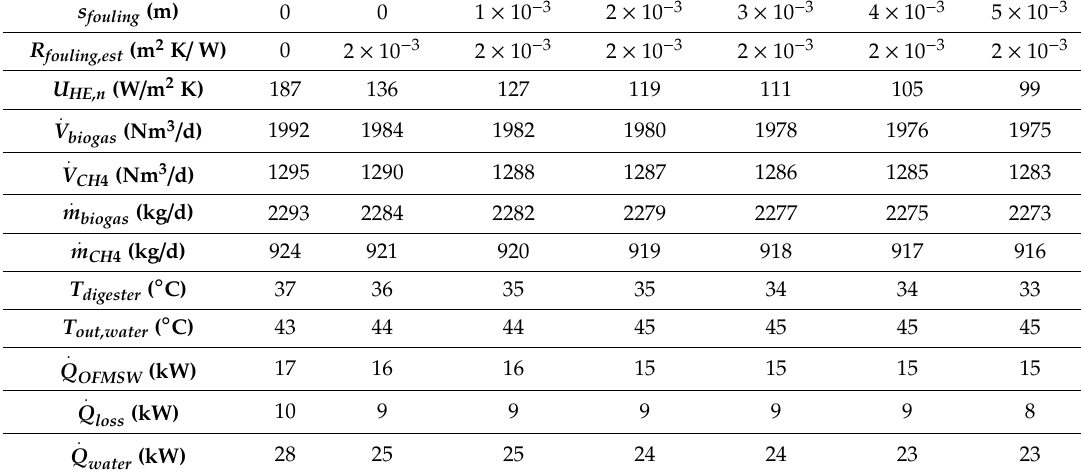
Figure 12. Thermal flow rates . m water = 0.557 kg / s and T in,water = 55 ◦ C. Table 11. Variation in model results due to internal and external fouling.